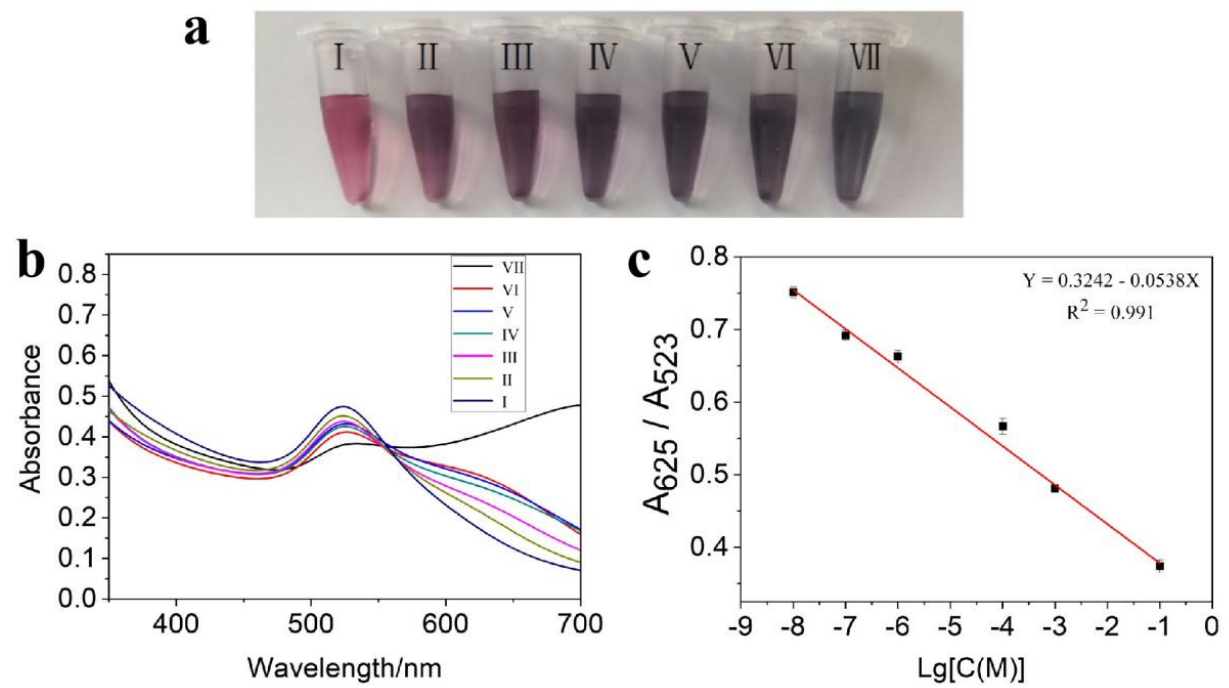
Figure 6. ( a ) Visual color changes of CeO 2 + ssDNA + AuNPs + NaCl in the presence of different concentrations of H 2 O 2 : (I) 0.1 M, (II) 1 × 10 − 3 M, (III) 1 × 10 − 4 M, (IV) 1 × 10 − 6 M, (V) 1 × 10 − 7 M, (VI) 1 × 10 − 8 M, and (VII) 0 M. ( b ) UV − vis absorption spectra change corresponding with ( a ). ( c ) The linear fitted curve presenting the A 625 /A 523 absorbance ratio at different concentrations of H 2 O 2 ; error bars